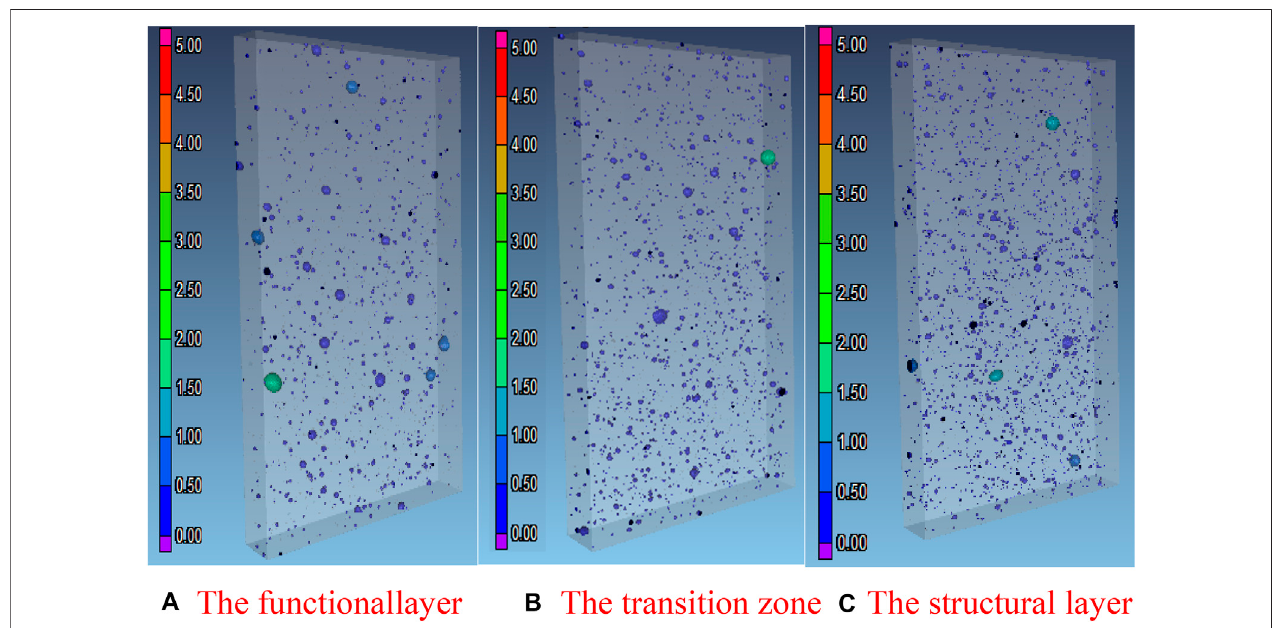
FIGURE 3 | The pore volume of the concrete (unit mm 3 ). (A) The functional layer (B) The transition zone (C) The structural layer.